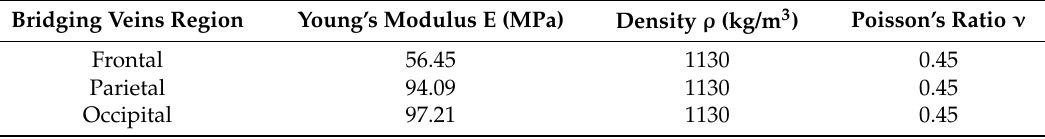
Table 2. Mechanical properties of bridging veins (samples from individuals older than 50 years of age) [41]. Bridging Veins